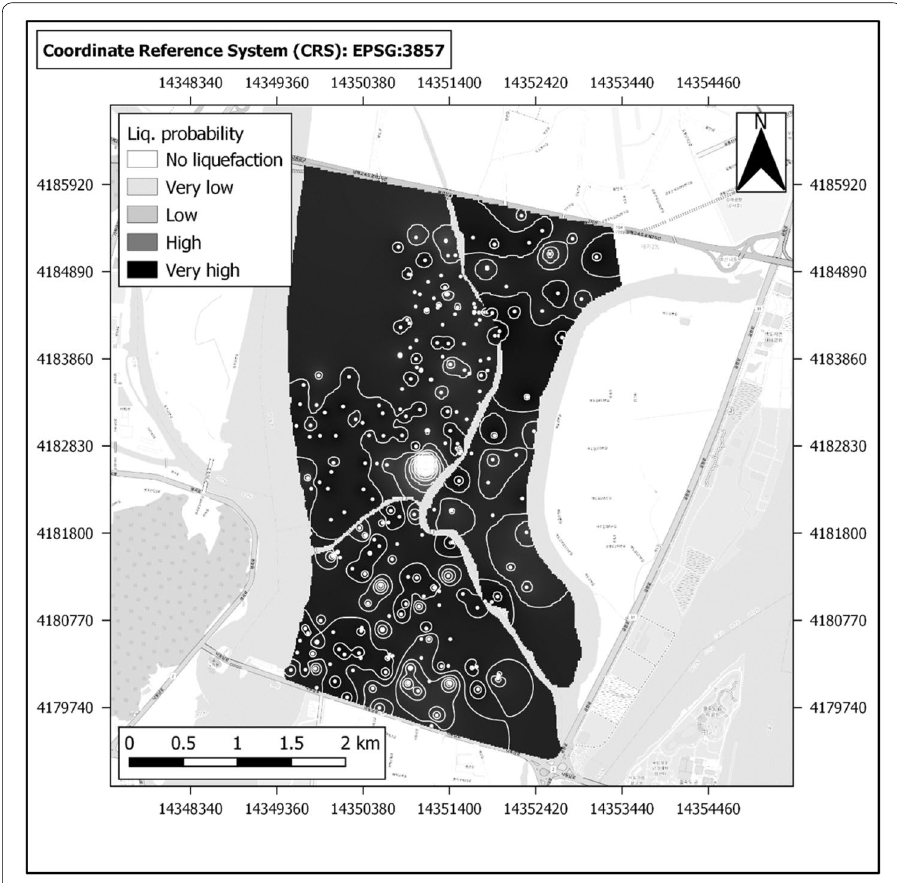
Fig. 22 Liquefaction hazard map based on reliability method for case